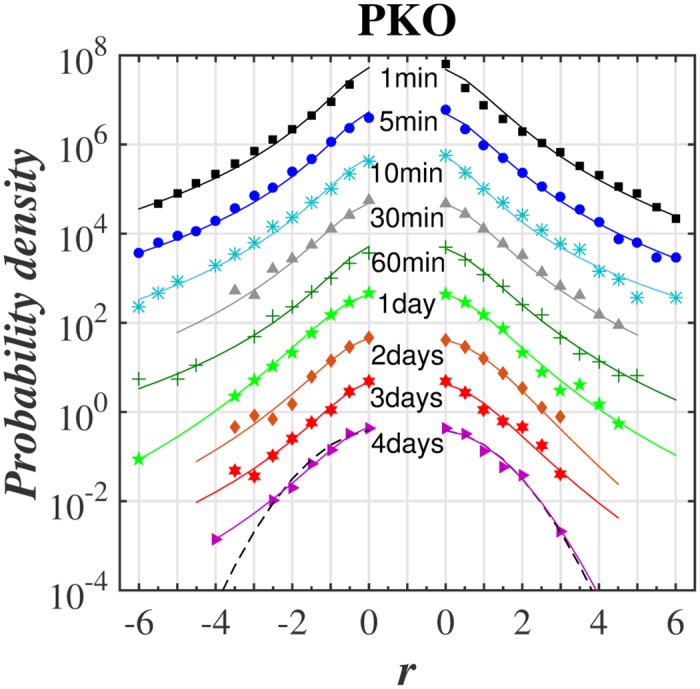
Same as in Fig 1 for PKO BP stock.